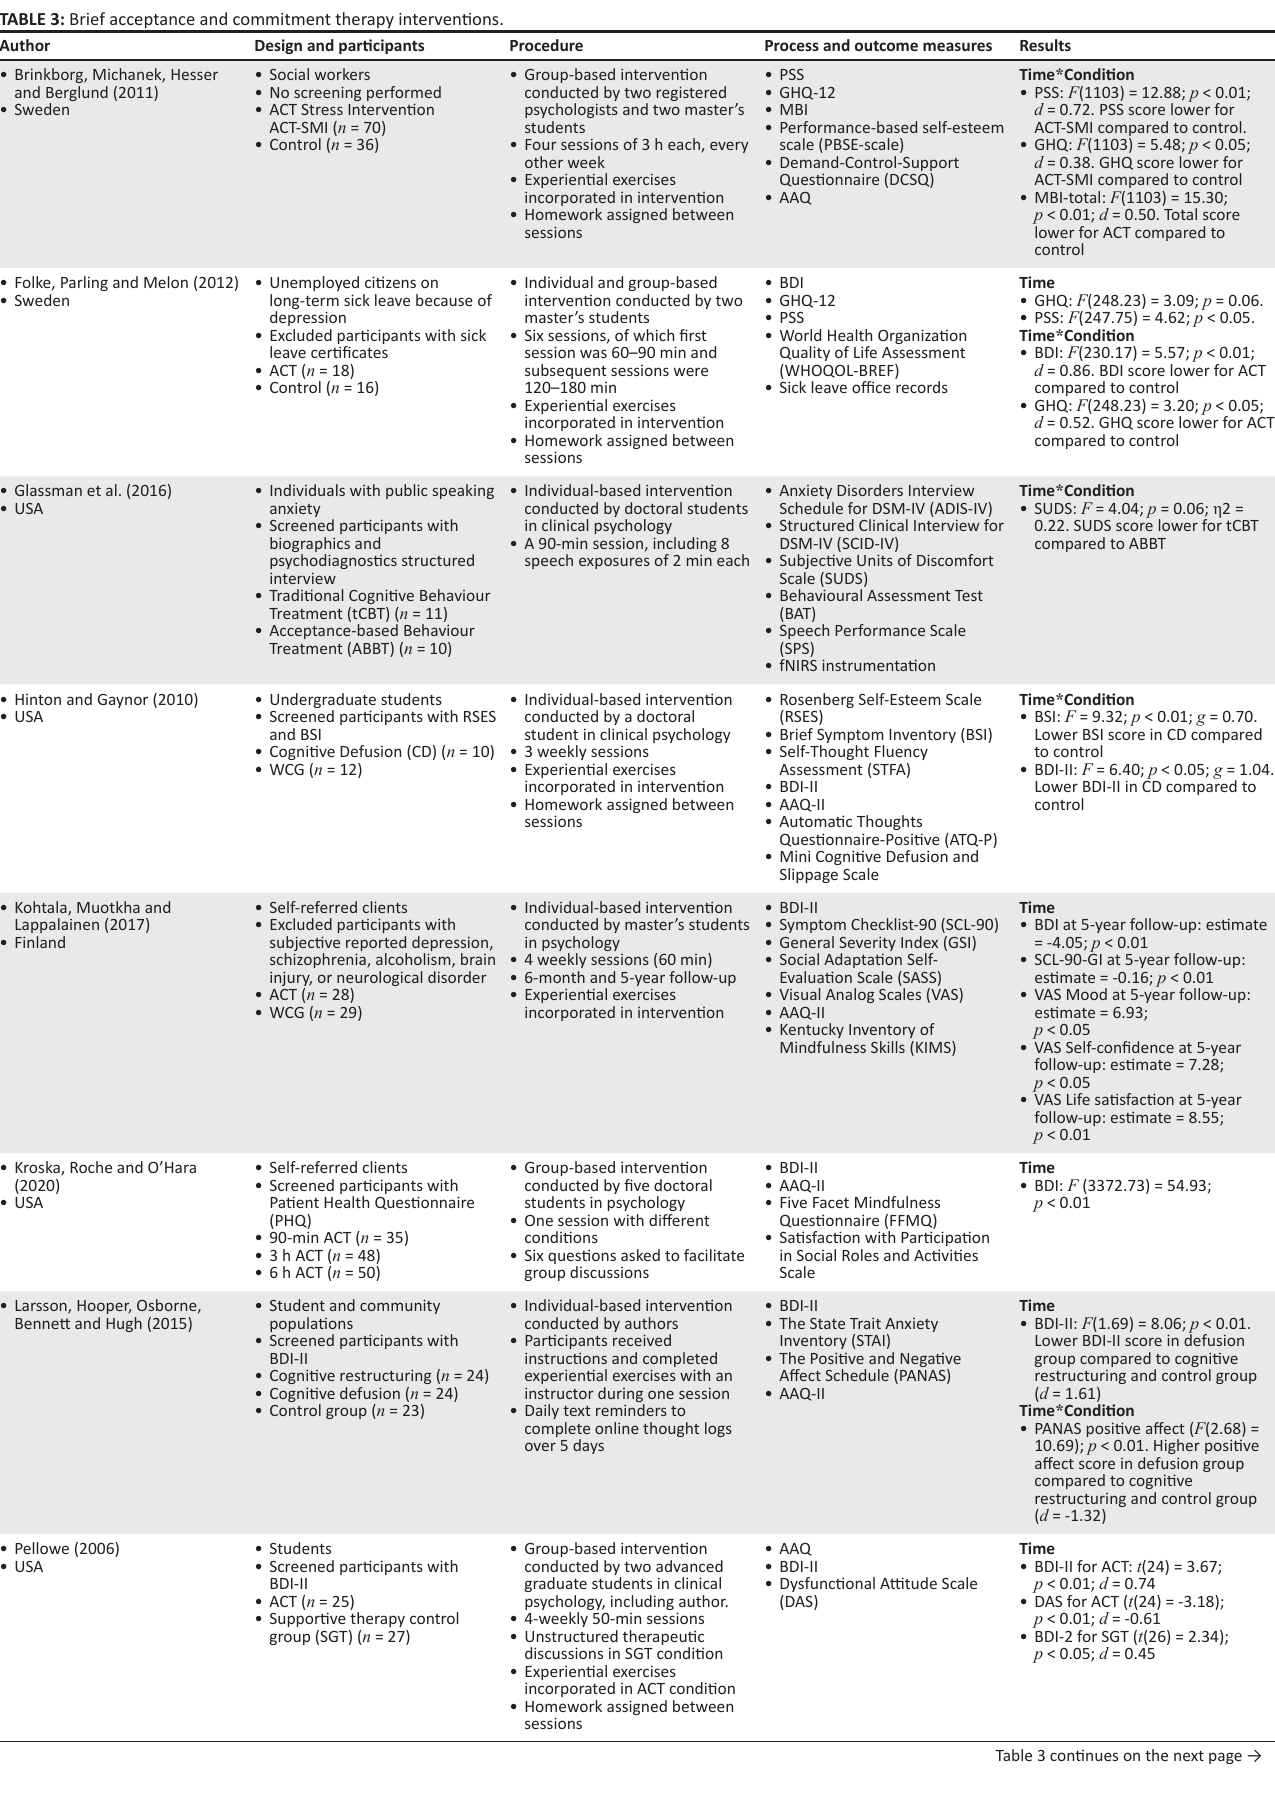
TABLE 3: Brief acceptance and commitment therapy